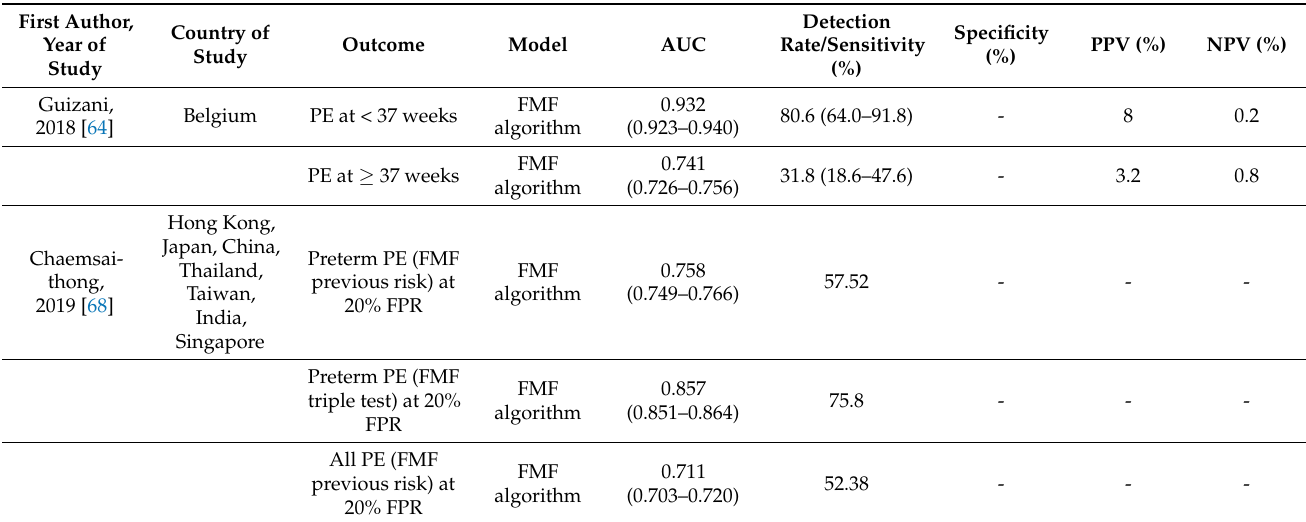
Table 3. Model performance metrics for HDP